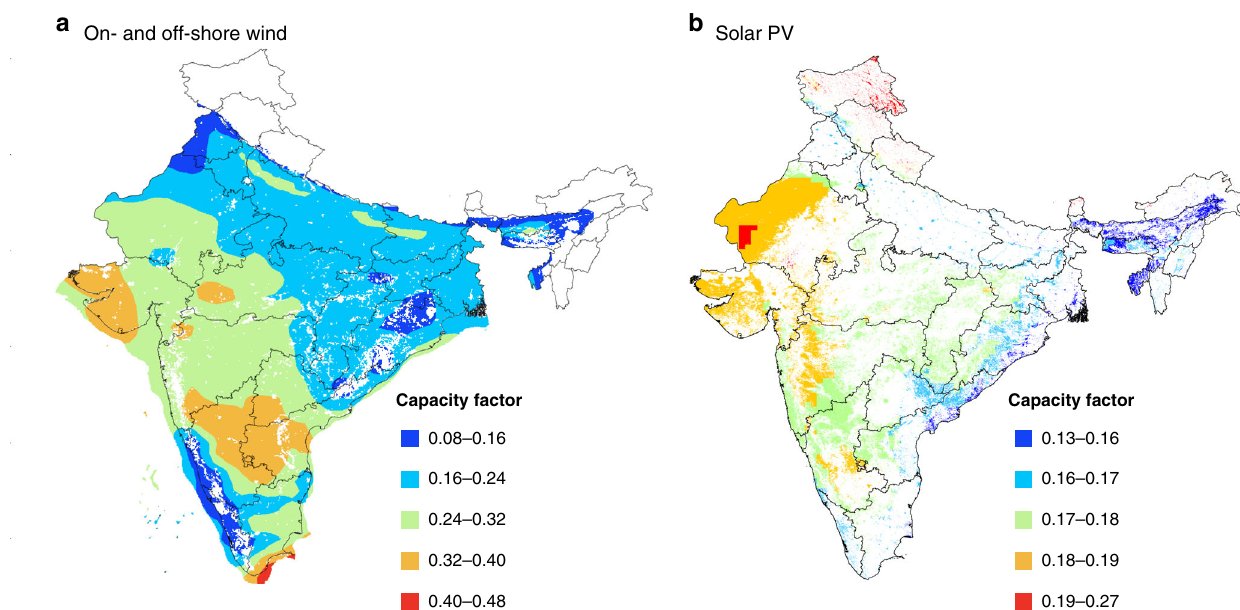
Fig. 1 Renewable capacity factors. Spatial distributions of mean annual capacity factors for a on- and offshore wind and b solar PV constructed based on meteorological output from the MERRA-2 reanalysis product. Regions indicated in white were excluded for the reasons discussed in the text. This fi gure was constructed in MATLAB version 2017b and edited in Adobe InDesign